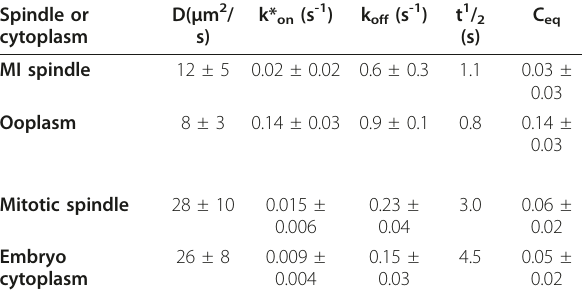
Table 1 g Tub37C kinetic parameters in the spindle and cytoplasm Spindle or